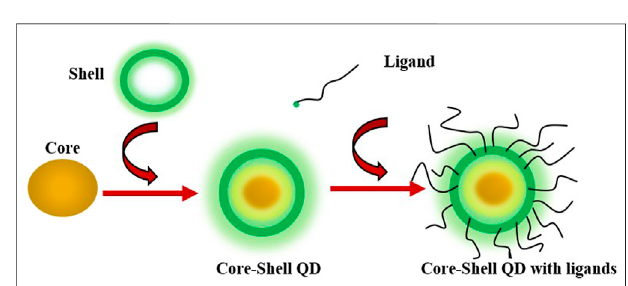
FIGURE 6 | Core-shell QDs interaction functionalized with ligand molecule